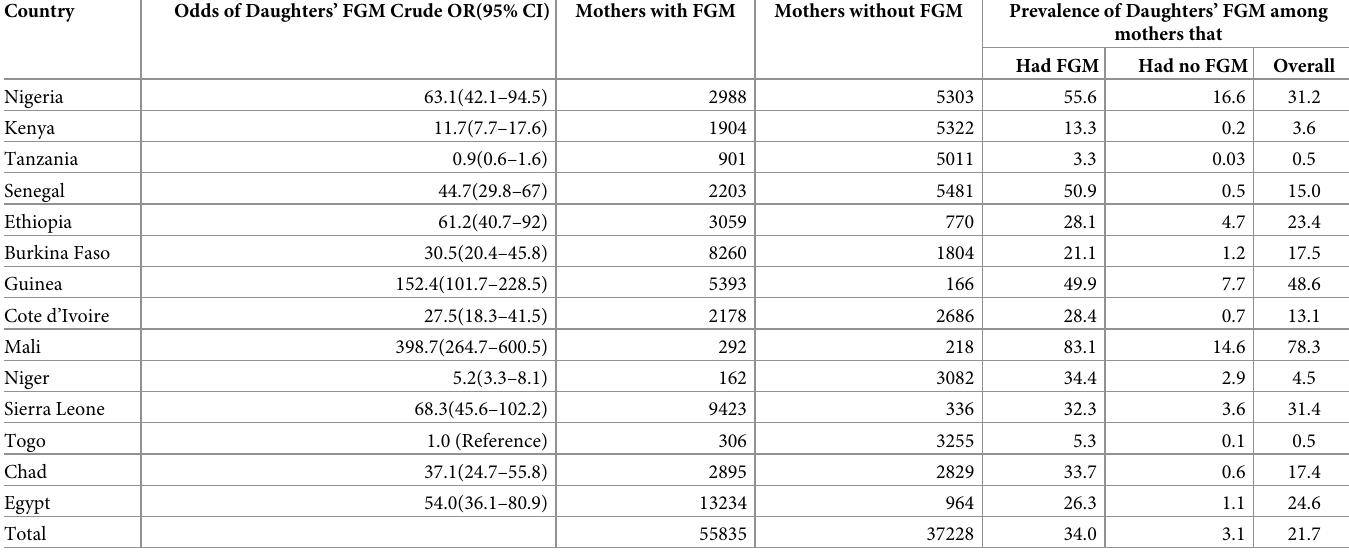
Binary multivariable hierarchical model. In an attempt to arrive at the best model that best predict mothers’ practice of FGM on their children, binary multilevel binary logistic regression models were fitted. We identified and fitted five models, and the results of these Table 3. The odds and distribution of daughters’ FGM among mothers in